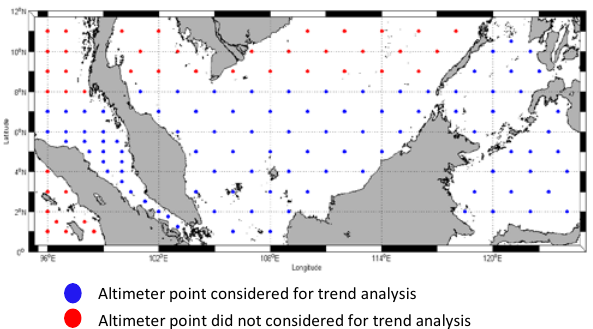
Figure 9. The locations of the absolute sea level trends extracted for further